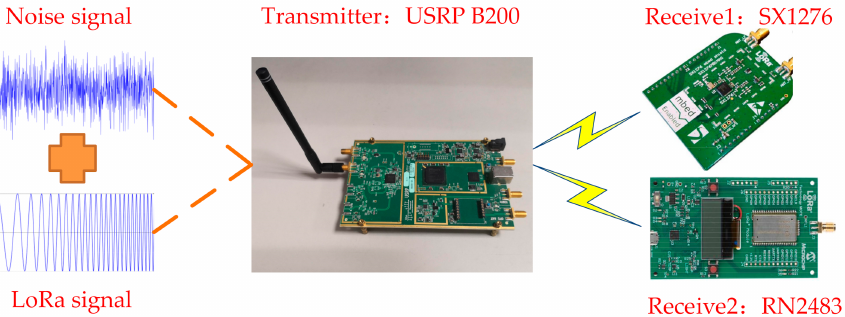
Figure 5. USRP B200 software radios were used to generate signals, which were superimposed by the LoRa signal and noise signal. SX1276 and RN2483 were used to receive